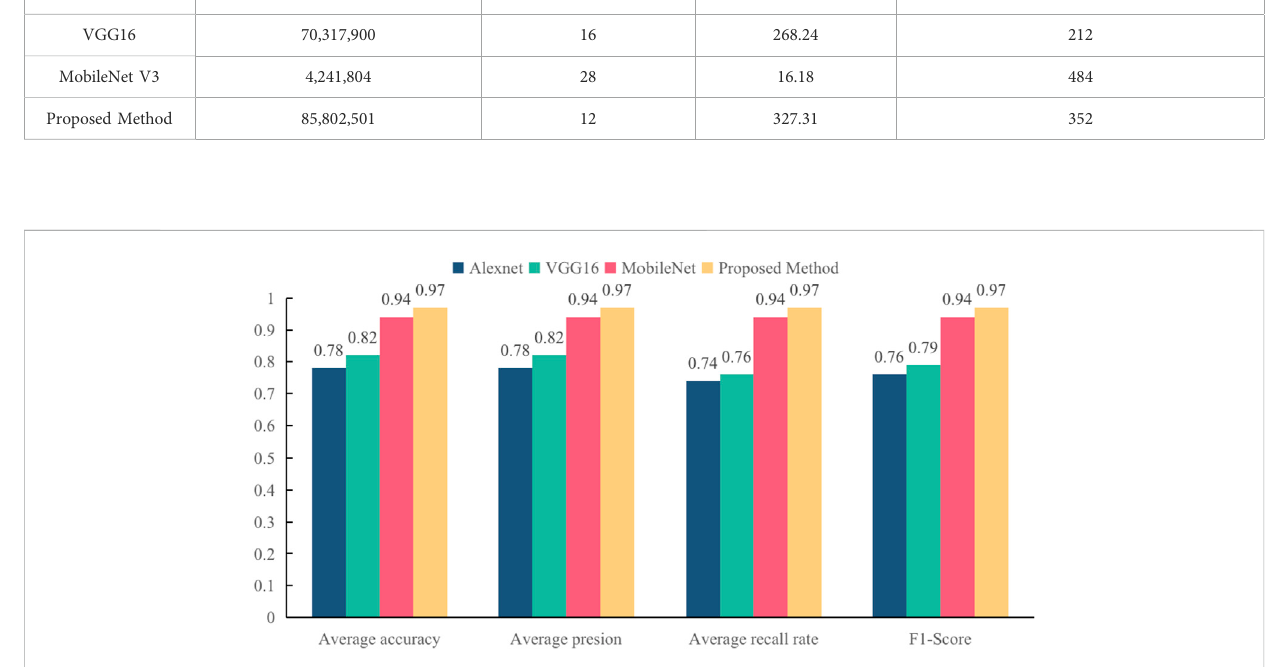
FIGURE 8 Accuracy rate, Precision rate, Recall rate, and F1 score of different